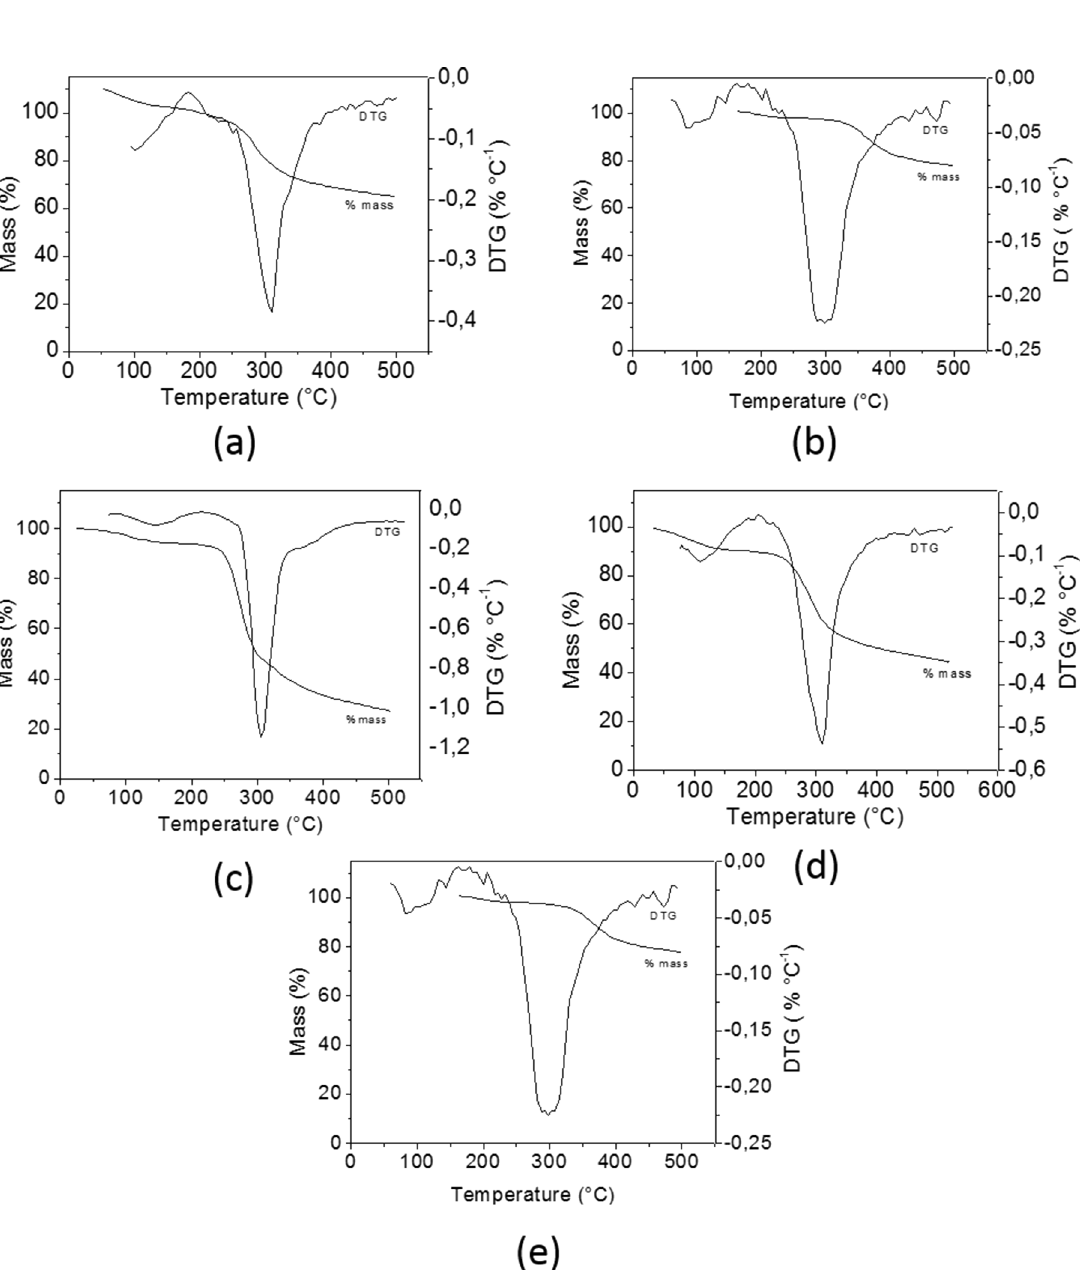
Table 1. Activities of free and immobilized lipases at different substrate concentrations. Kinetic parameters (k immobilized lipase. Catalytic efficiency and variation (R 2 ).